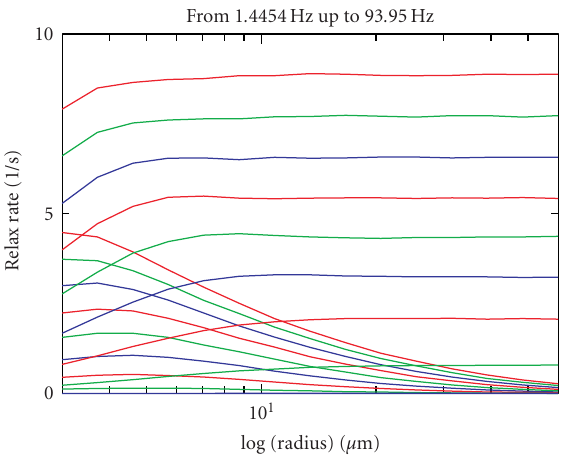
Figure 4: R2/R2 ∗ relaxation rate (in s − 1 ) for SE, GE, from de- oxygenation corresponding to a frequency of 1.4454 Hz to 65 × 1.4454 Hz. Data are shown in steps of 8 × 1.4454 Hz. The time step length in these computations was 10microseconds. The mean value for 8 computations with di ff erent random series initialization is